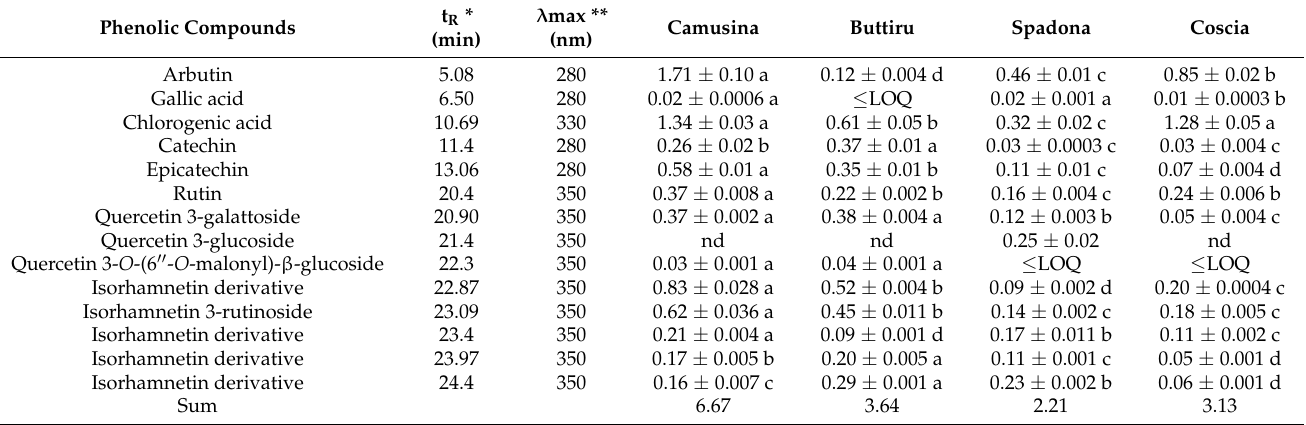
Table 6. HPLC analysis of individual phenolic compounds (mg g − 1 DM) in the fruit peel of the investigated pear cultivars.